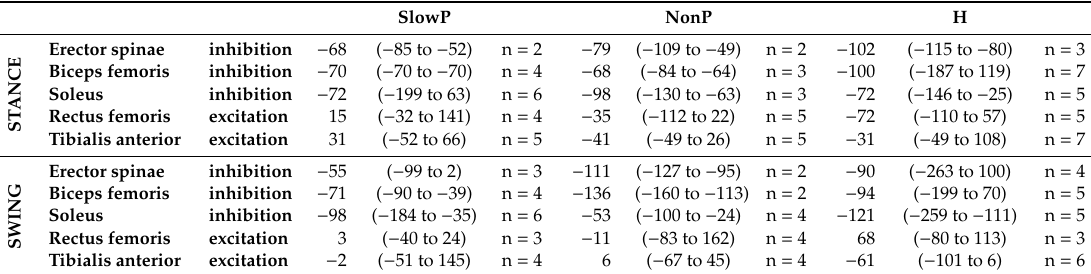
Table 5. Latencies (ms) of postural EMG changes with respect to the APA onset (time 0). Median, minimum, and maximum values, together with the number of subjects (n) in which APAs could be identified, for children with slow progressive PCA (SlowP), children with non-progressive PCA (NonP), and healthy children (H). EMG: electromyographic; APA: anticipatory postural adjustment. SlowP NonP H